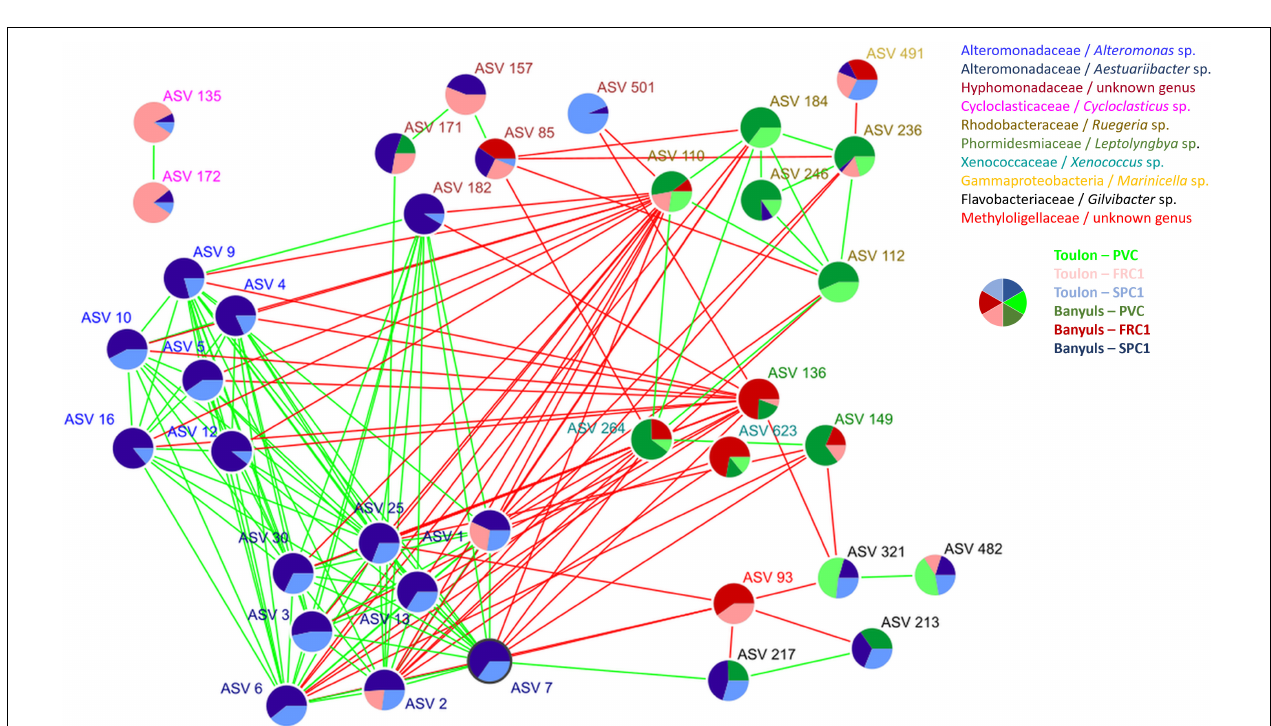
FIGURE 8 | Network co-occurrence analysis performed with CONET for samples after 75 days of immersion at both sites. Colors of ASVs corresponded to genera while pie charts indicated their relative abundance on the three coatings (PVC, SPC1, and FRC1) at the two sites (Toulon and Banyuls). structures (as flagella, fimbriae, pili or curli) or adhesins are